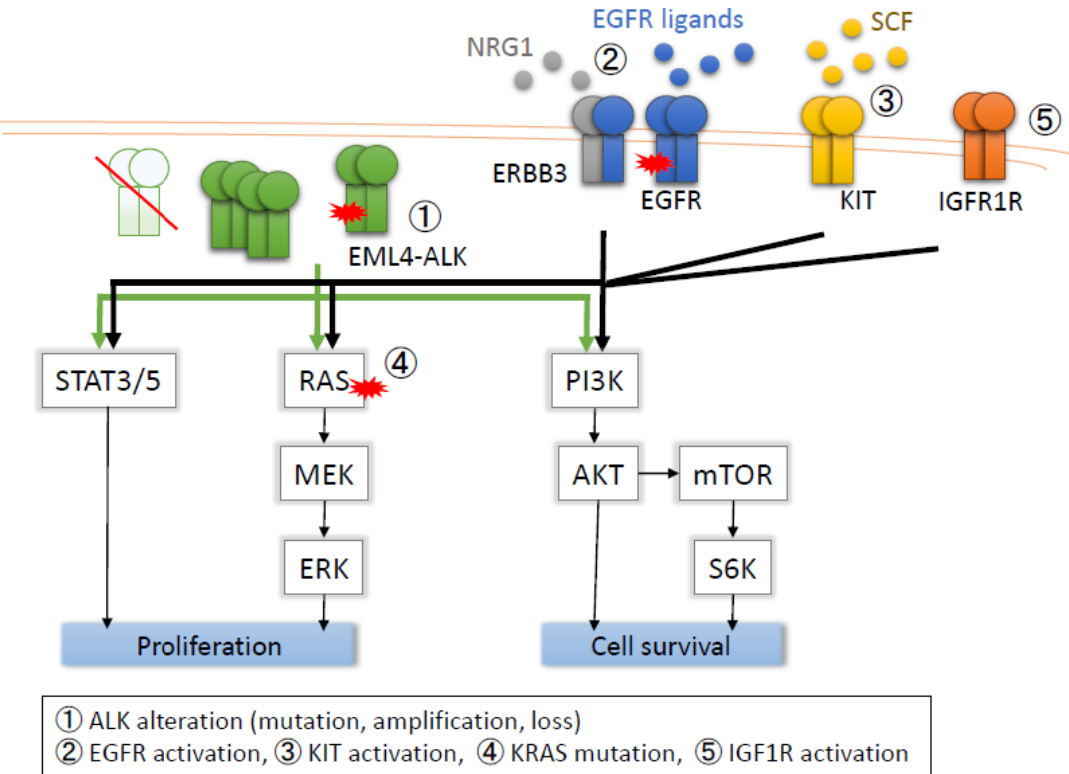
Figure 1. Mechanisms of resistance to